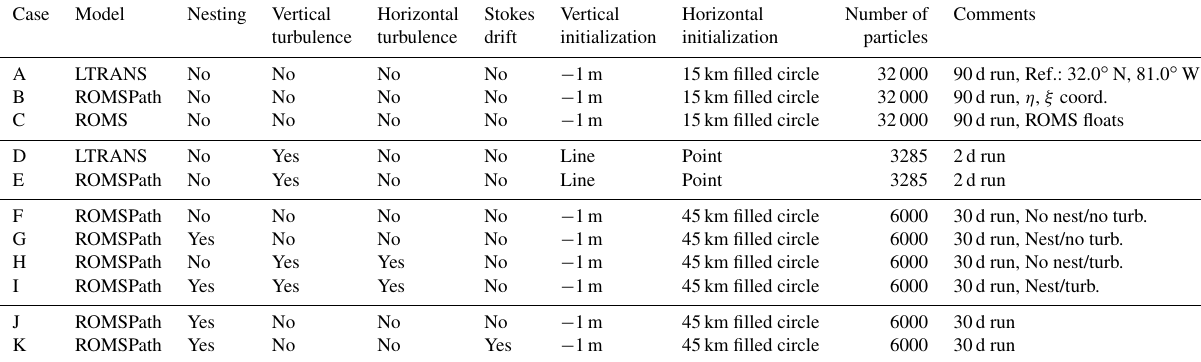
Table 1. Particle tracking model simulation configurations for cases A–K. All cases use either LTRANS, ROMSPath, or the ROMS online float subroutine as an advection model. Cases with nesting use data from both SnailDel and Doppio for advection while cases without nesting include Doppio data only. The vertical turbulence parameterization is used in cases D, E, H, and I only, and horizontal turbulence is used in cases H and I. Stokes drift was active in case K only. Particles in all cases except D and E are initialized at − 1m depth and randomly distributed in a circle. In cases D and E particles are evenly spaced vertically ( ∼ 34m depth) at a single horizontal